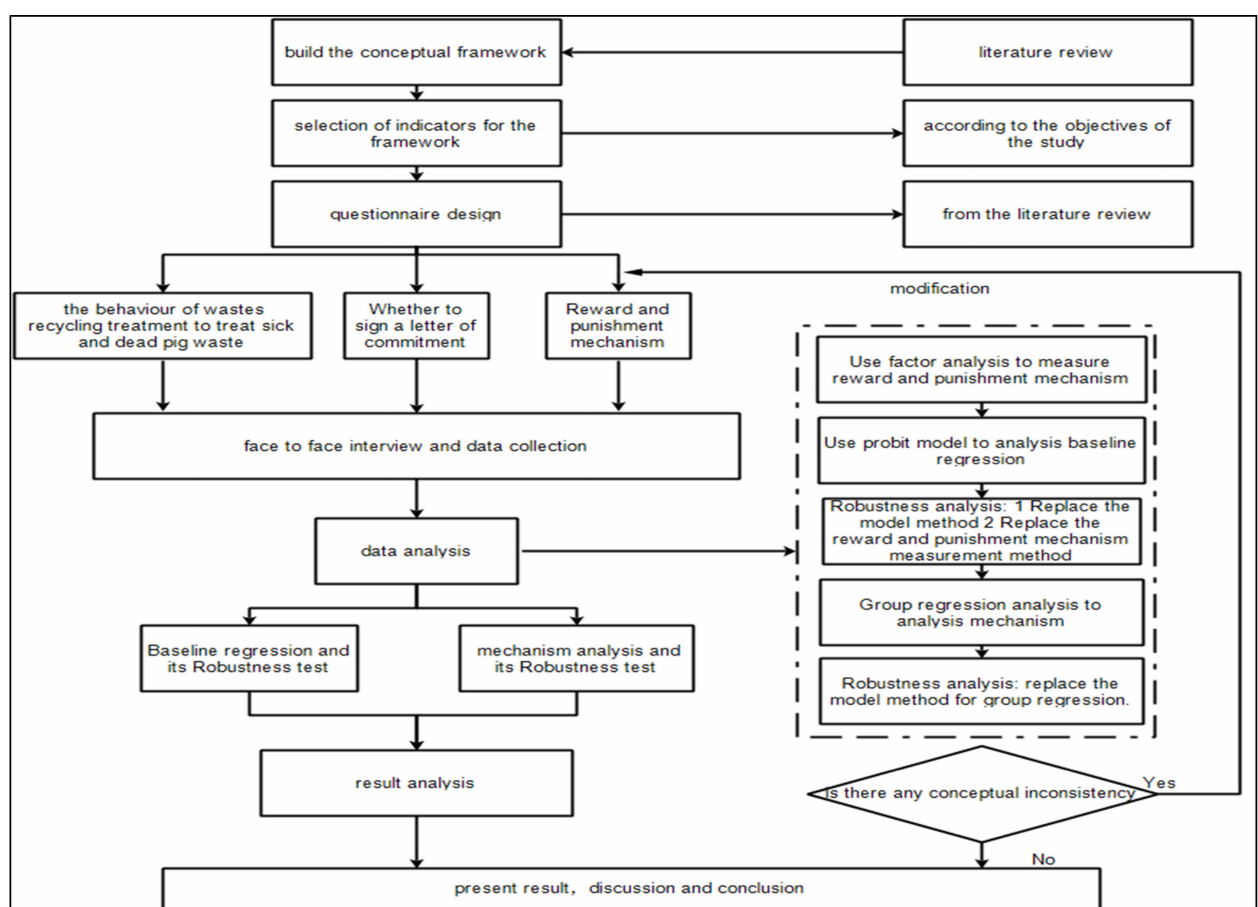
Figure 1. Adopted methodology of the